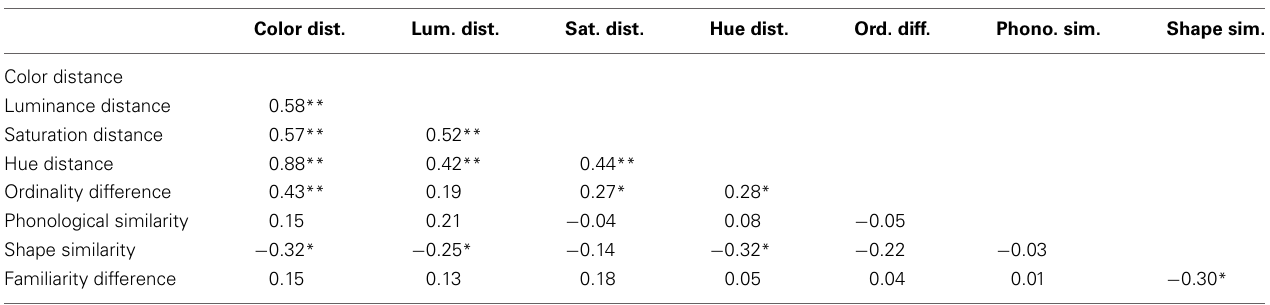
Table 3 | Correlations among the variables for English alphabet letter pairs ( N = 65). Color